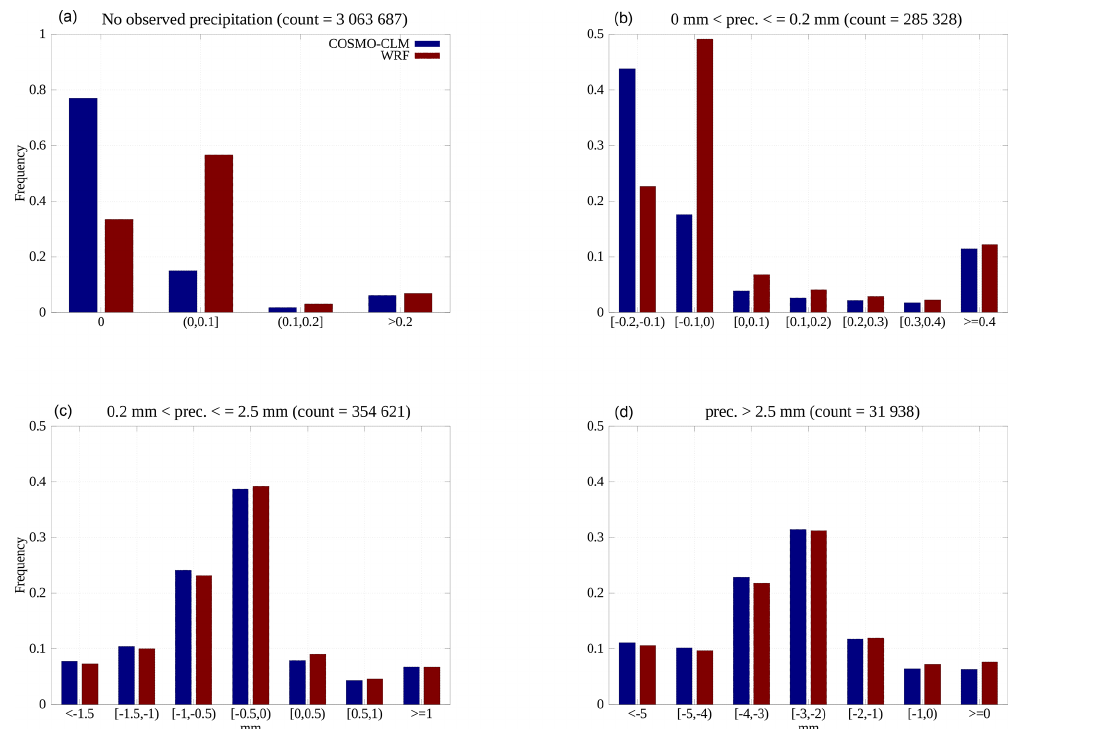
Figure 7. Bar graphs showing the precipitation error distributions found for the COSMO-CLM (in blue) and WRF (in red) models and cate- gorised according to observed hourly station amounts. (a) No precipitation; (b) light precipitation (0mm, 0.2mm]; (c) moderate precipitation (0.2mm, 2.5mm]; (d) heavy precipitation, > 2 .